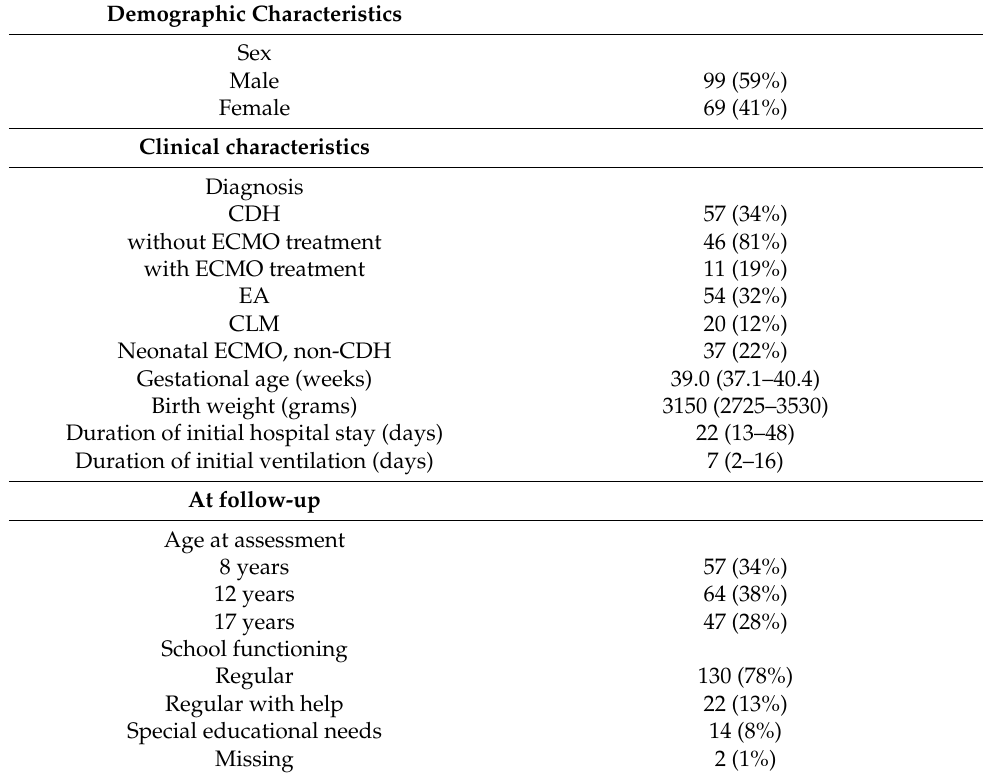
Table 1. Demographic and clinical characteristics of 168